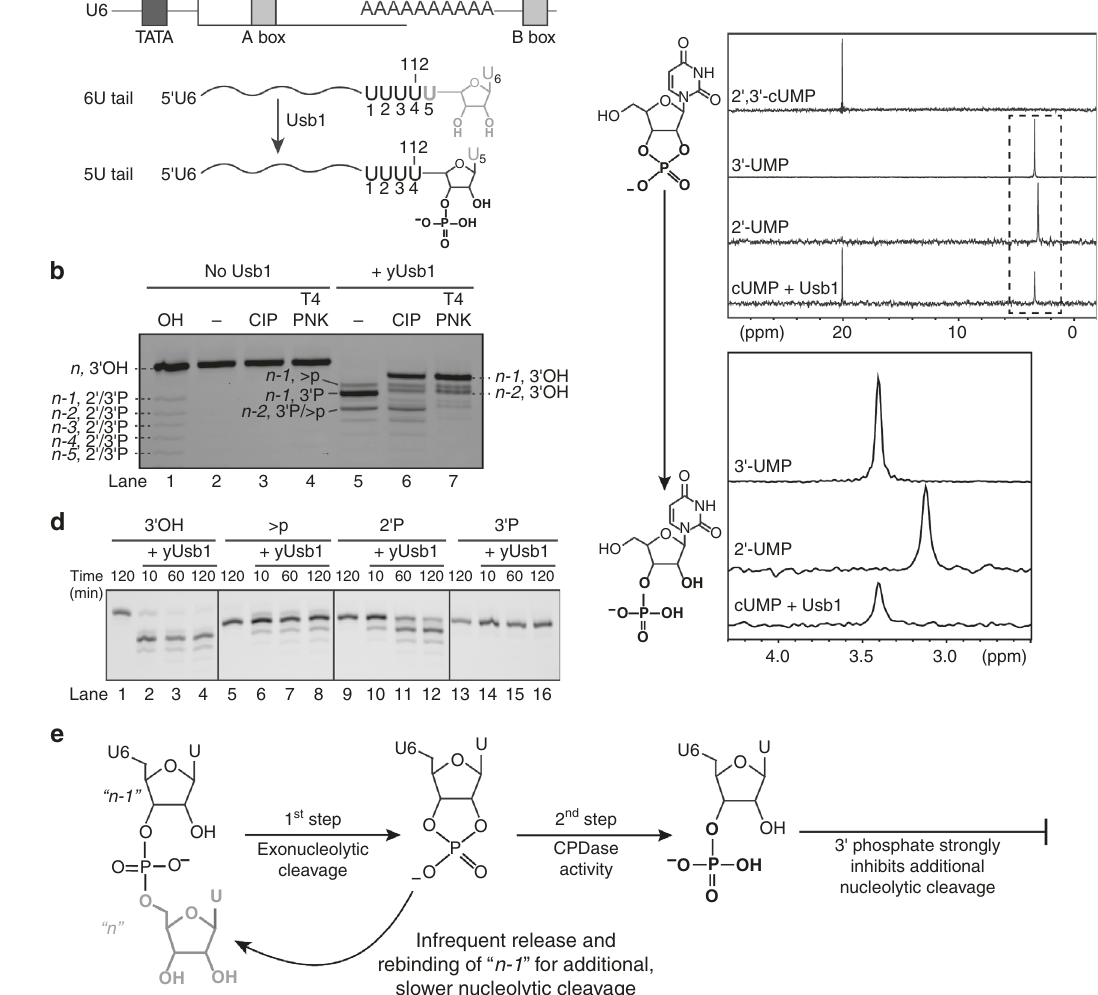
Fig. 1 yUsb1 acts as a 3 ′ – 5 ′ exonuclease and CPDase in vitro. a U6 snRNA is synthesized by RNA Polymerase III. Transcription termination produces a heterogeneous U6 with a 4 – 8 nucleotide U-tail. Processing by yUsb1 shortens the U-tail and leaves a phosphoryl group. b Usb1 removes nucleotides from the 3 ′ end of RNAs. The 5 ′ -labeled U6 95 – 112+3U oligonucleotide cis -diol substrate (lane 2) is insensitive to CIP (lane 3) or T4 PNK (lane 4) treatment. Incubation with yUsb1 for 1 h results in a shorter product (lane 5). Similar reactivity of the product to both CIP (lane 6) and T4 PNK (lane 7) indicates that the product is a noncyclic phosphate. An alkaline hydrolysis ladder (lane 1) shows the mobility of oligonucleotide products of different lengths. ( c , top ) One-dimensional 31 P NMR spectra of 2 ′ ,3 ′ -cUMP shows a single peak at 20 ppm. A 3 ′ UMP standard has a single peak at 3.4 ppm. When 2 ′ ,3 ′ -cUMP is incubated with AtRNL, which leaves a 2 ′ phosphate 8 , there is a single peak at 3.2 ppm. Incubation of 2 ′ ,3 ′ -cUMP with yUsb1 produces a new signal at 3.4 ppm ( c , bottom ) Zoom of dashed region in top panel. d Time course of Usb1 processing on RNAs with different 3 ′ end modi fi cations. yUsb1 is most active on RNA substrates with a cis -diol (lanes 1 – 4), less active on those with a 2 ′ ,3 ′ -cyclic phosphate ( > p; lanes 5 – 8) or 2 ′ phosphates (2 ′ P; lanes 9 – 12), and is inactive on 3 ′ phosphate ends (3 ′ P; lanes 13 – 16). e Model describing the dual activities of